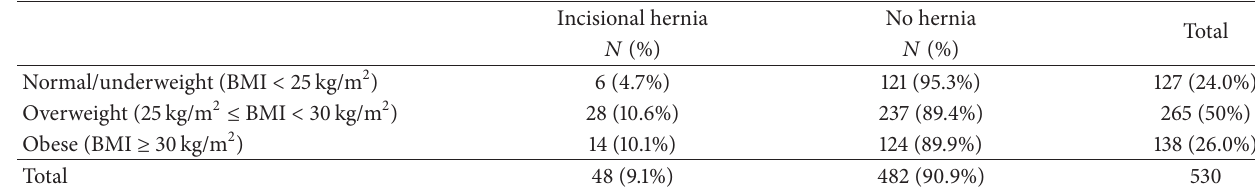
Table 2: Patients classified by BMI and incisional hernia